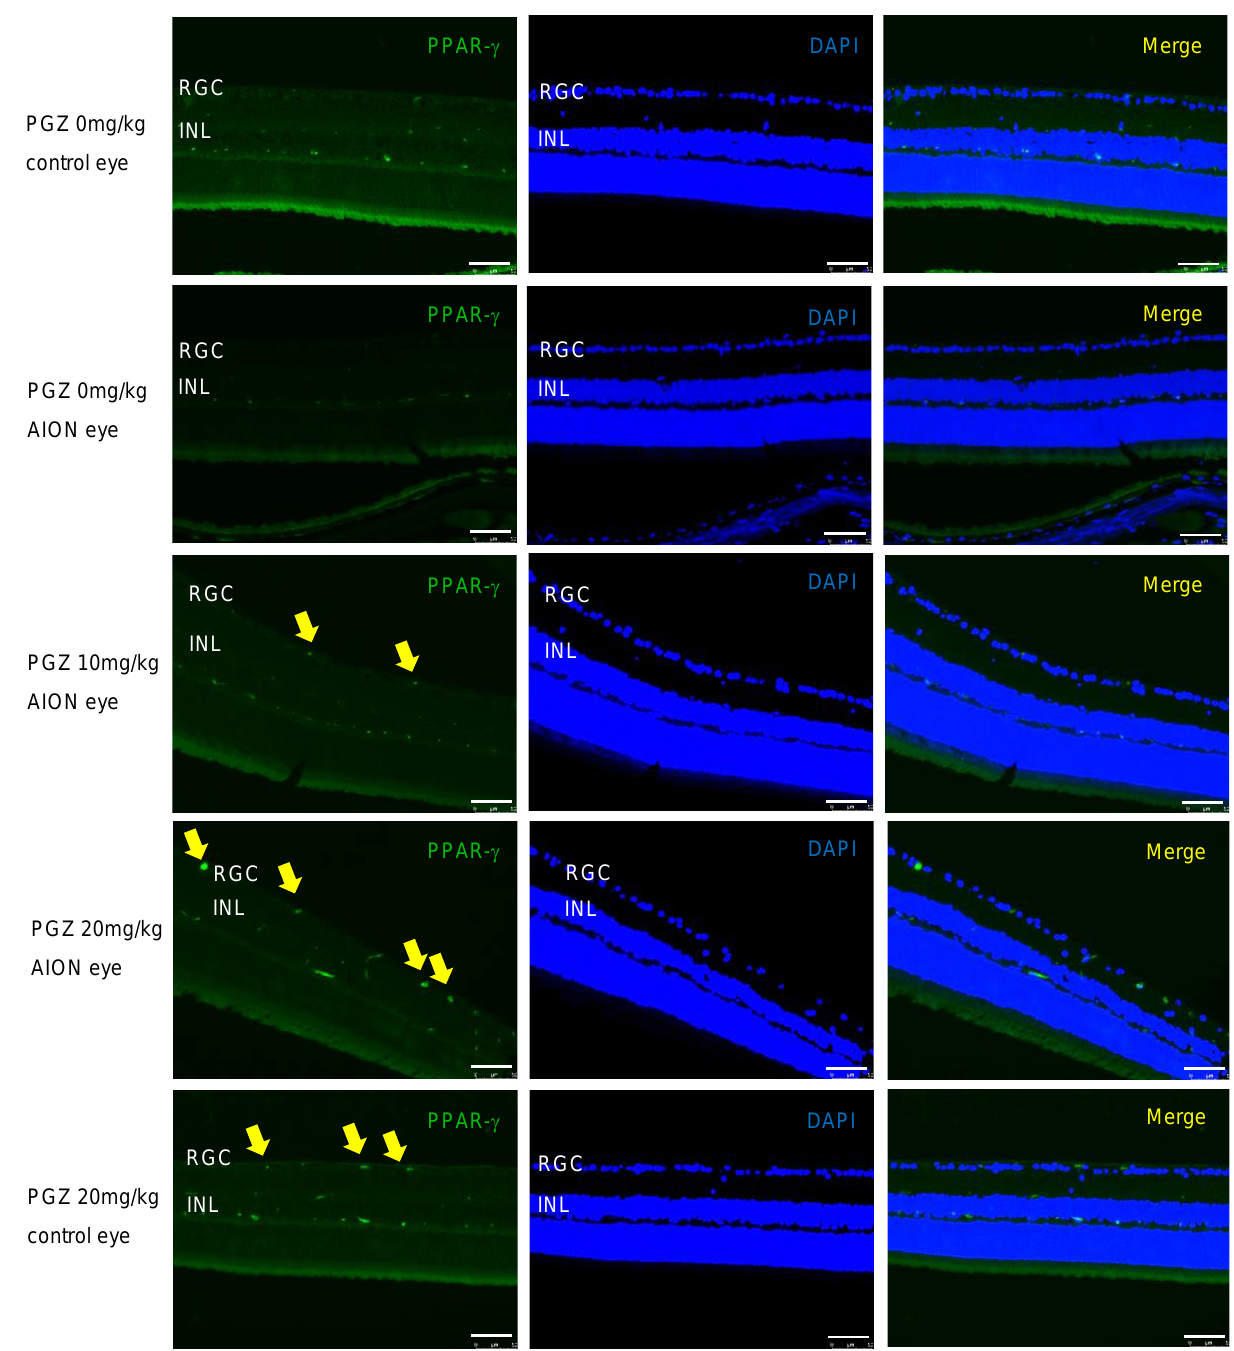
Figure 5. PPAR- γ expression in the retina. The representative figures show that PPAR- γ was barely detected in the retina of diabetic mice without AION and in retina of AION eyes in diabetic mice without treatment of PGZ. PPAR- γ (yellow arrows) expression was more significant in the retina of AION eyes in diabetic mice treated with 20 mg/kg PGZ than in that of diabetic mice treated with 10 mg/kg PGZ and retina of normal eyes in diabetic mice treated with 20 mg/kg PGZ (scale bar: 75 μm; magnification: 200 ×